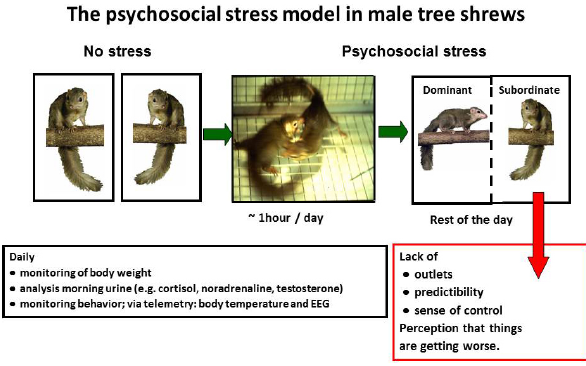
Figure 5. Schematic presentation of the psychosocial stress model in male tree shrews. For the subordinate male the situation is charac- terized by a lack of outlets, no predictability and no sense of